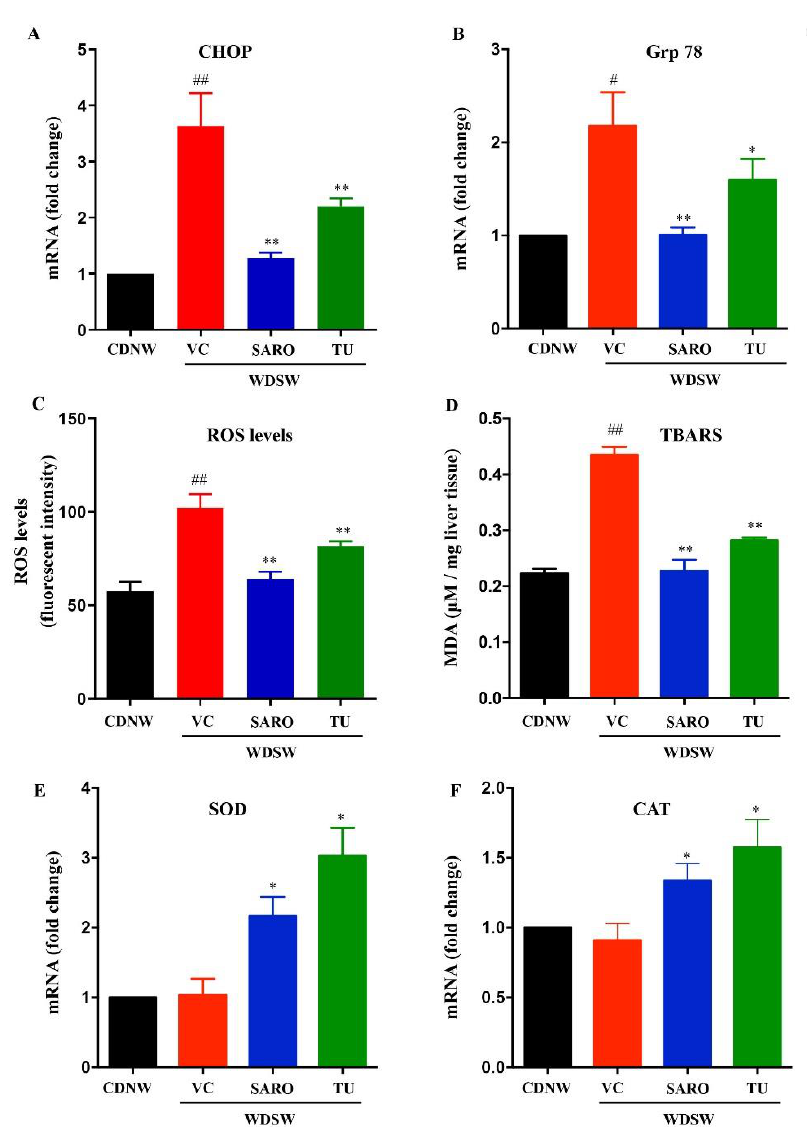
Figure 6. Effect of Tecomella undulata ( TU ) on ER stress and oxidative stress in NASH mice. The relative expression of hepatic mRNA levels of CHOP ( A ), Grp78 ( B ), SOD ( E ), and CAT ( F ) were determined using qRT-PCR. The experiments were carried out in triplicate and β -actin was used as an endogenous control for normalizing the mRNA levels. Intracellular ROS production ( C ) and lipid peroxidation (MDA levels) ( D ) were determined in the liver tissues of CDNW and WDSW mice treated with vehicle control (VC), saroglitazar (SARO) or Tecomella undulata (TU). Data are expressed as the mean with SEM for 8–10 mice per group. ## p < 0.001 or # p < 0.05 compared to CDNW; ** p < 0.001 or * p < 0.05 compared to WDSW, vehicle control. CHOP, C/EBP homologous protein; Grp78, 78 kDa glucose regulated protein; SOD, superoxide dismutase; CAT, catalase; ROS, reactive oxygen species; MDA,